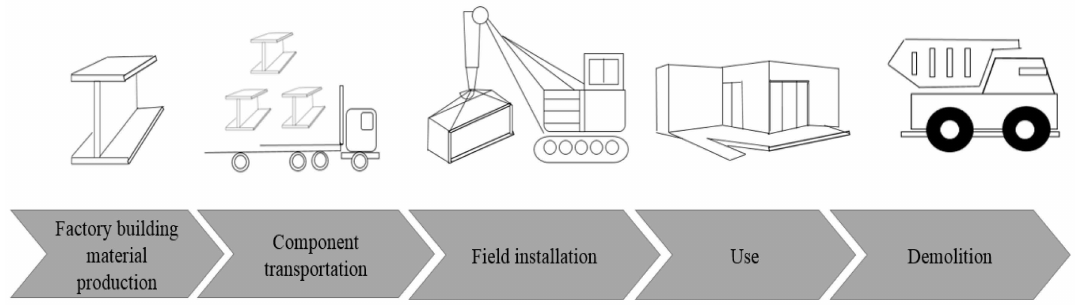
Figure 1. Division of the life cycle of prefabricated buildings.